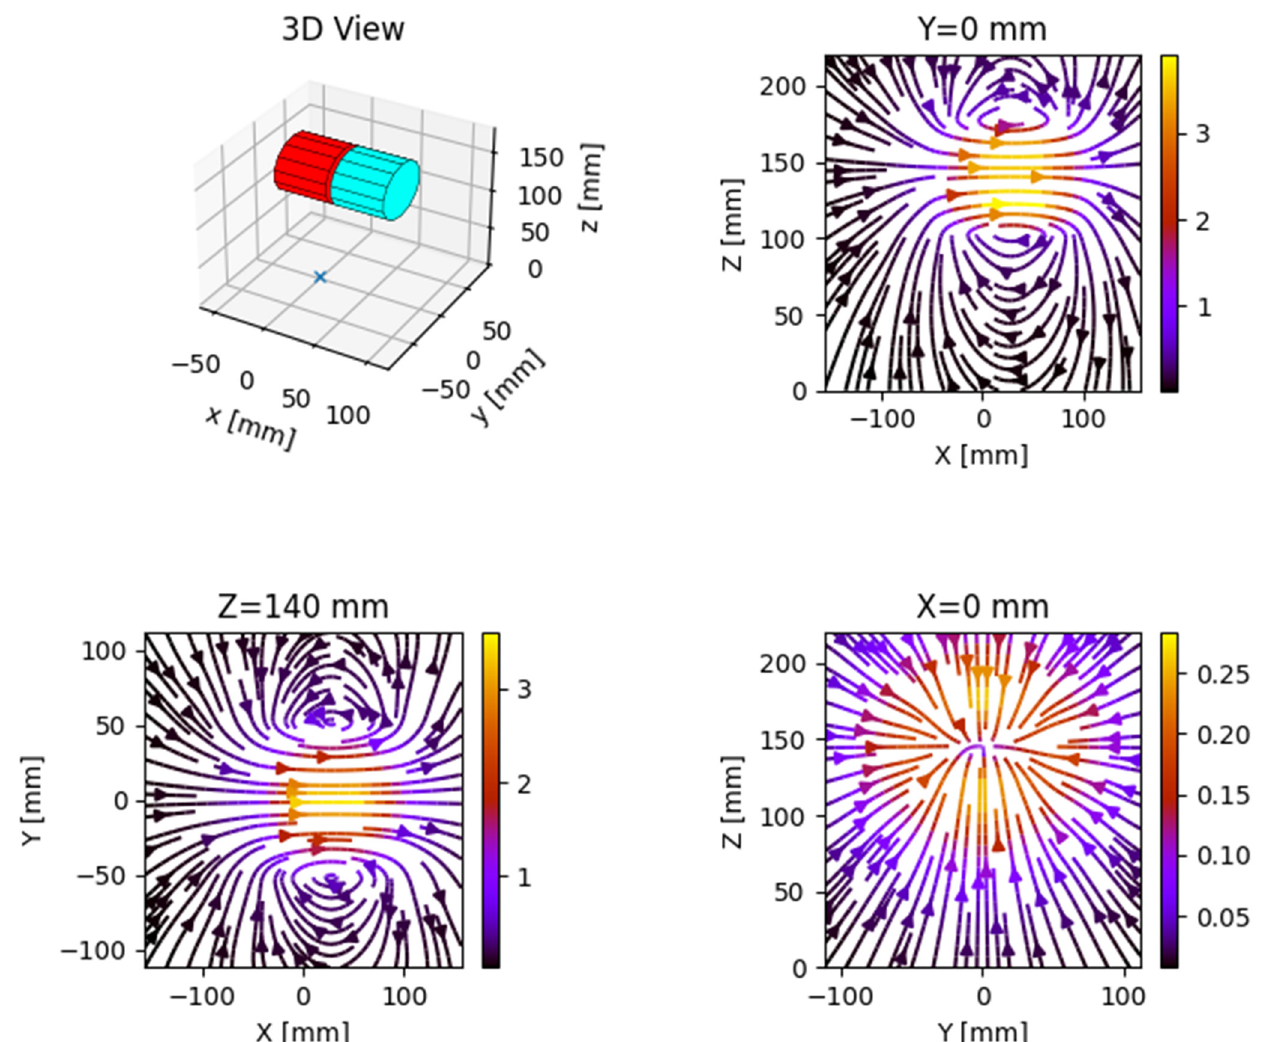
Figure 4. The appearance of the magnetic field simulated with Magpylib.